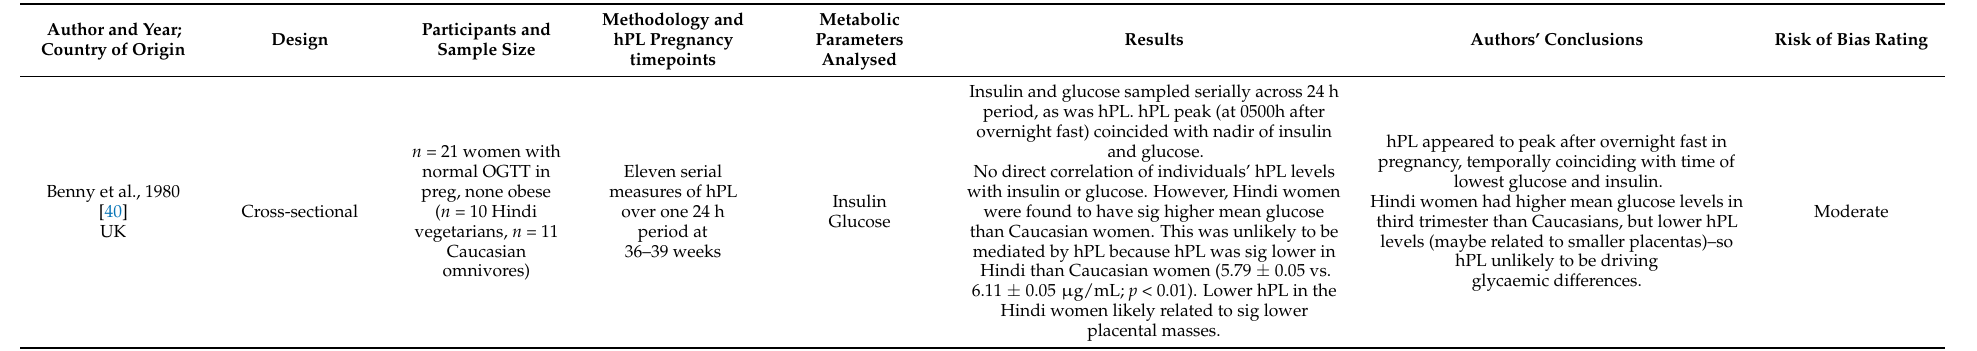
Table A3. Studies examining hPL in relation to glycaemic or insulin-related parameters in pregnancy/postpartum—5